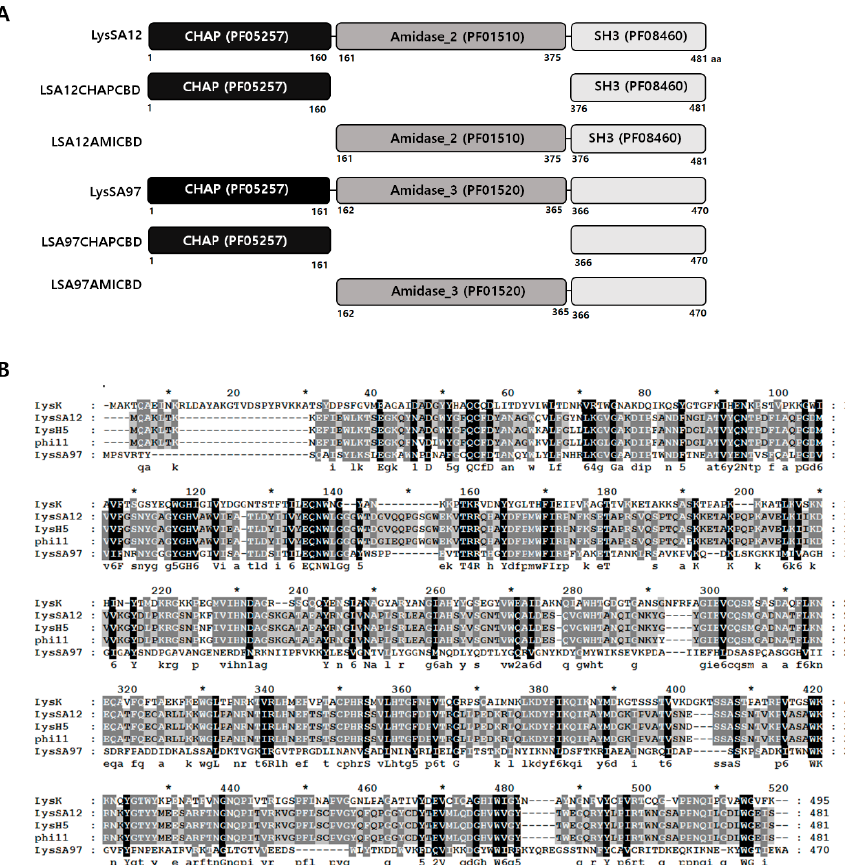
Figure 1. Modular structure of LysSA12 and LysSA97. ( A ) Schematic representations of LysSA12, LysSA97, and their deletion constructs. The numbers indicate the initial and final amino acids in the domains as determined using the Pfam domain database. CHAP domain, black box; amidase domain, dark grey box; CBD, light grey box; ( B ) Sequence alignment of LysSA12 and LysSA97 with other related endolysins. LysK, S. aureus phage K endolysin; LysH5, S. aureus phage vB_SauS-phiIPLA88 endolysin; phi11, S. aureus phage phi11 endolysin. Conserved and identical residues are shaded in gray (dark gray, >70% conserved; light gray, >40% conserved) and black, respectively. The conserved Cys-His-Asn triad is indicated by triangles.